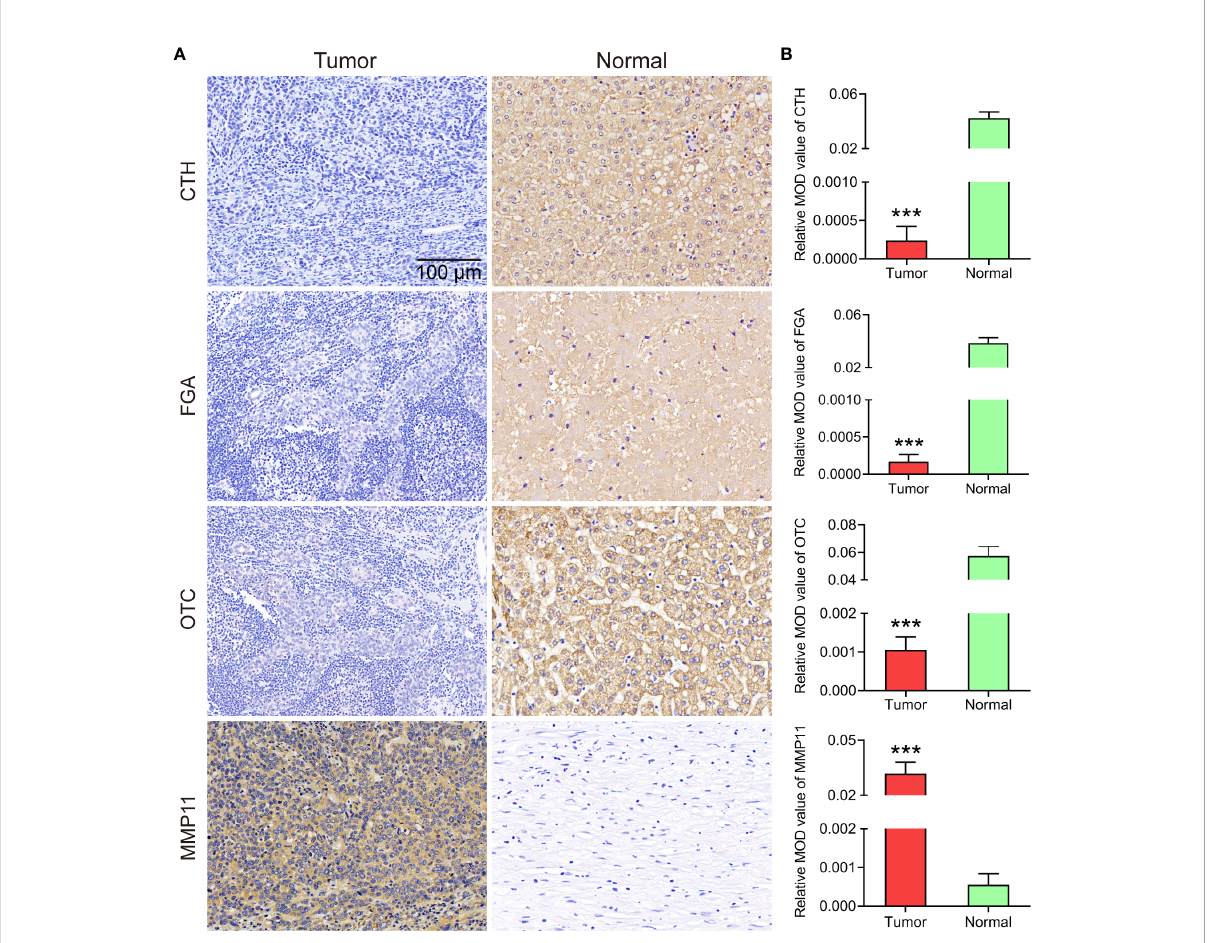
FIGURE 7 (A) Representative images of IHC staining from eleven primary CCA specimens and eleven paracancer normal tissue specimens (200x magni fi cation). (B) Statistical analysis of the mean optical density (MOD) of CTH, FGA, OTC and MMP11 staining in CCA specimens and normal tissues. The bar chart shows the mean ±SEM of more than three independent experiments (*** P <